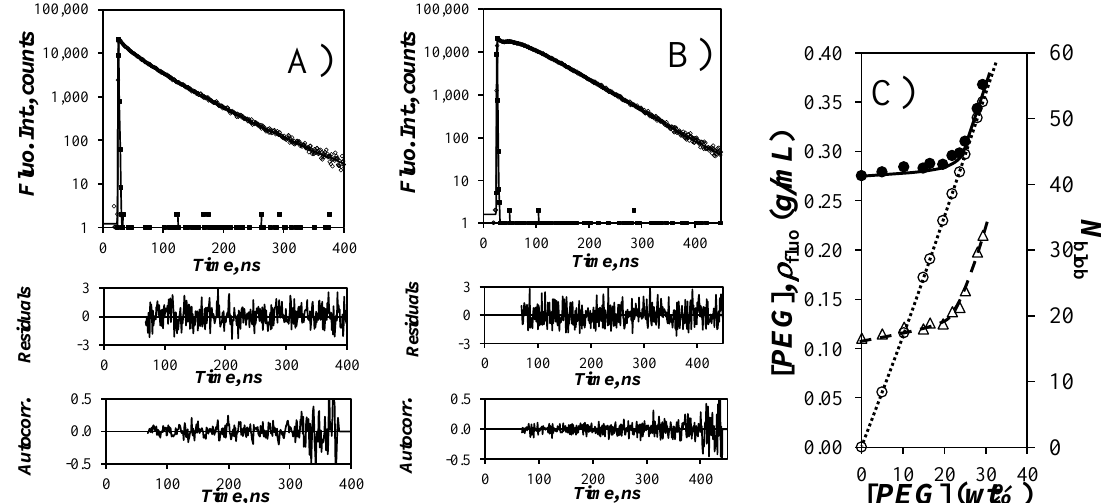
Figure 5. Fluorescence decays of the pyrene ( A ) monomer and ( B ) excimer of Py(4.8)-NAF57 in DMSO with 0.32 g/mL PEG(5.0K). ( C ) Plot of ( , right axis) N blob , ( ) PEG(5.0K) concentration, and ( ) ρ fluo as a function of PEG(5.0K) wt%. [Py(4.8)-NAF57] = 9.1